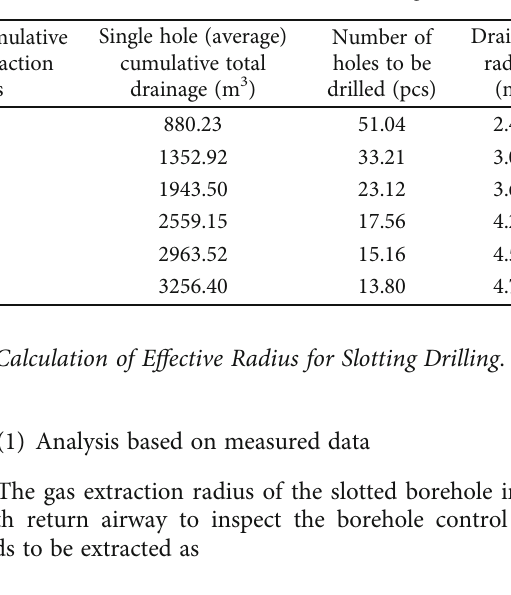
Figure 24: Variation curve of daily average scalar extraction volume with time in common extraction Table 1: Calculation results of kerf drilling radius.